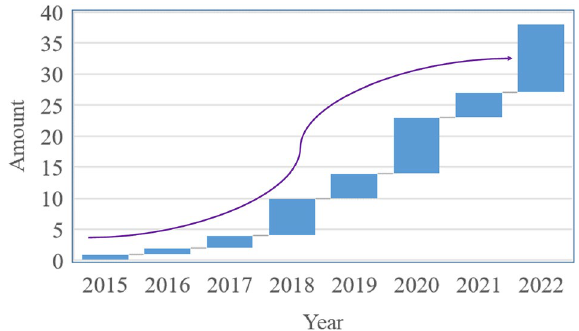
Figure 4. Temporal trends of biobanks establishment.